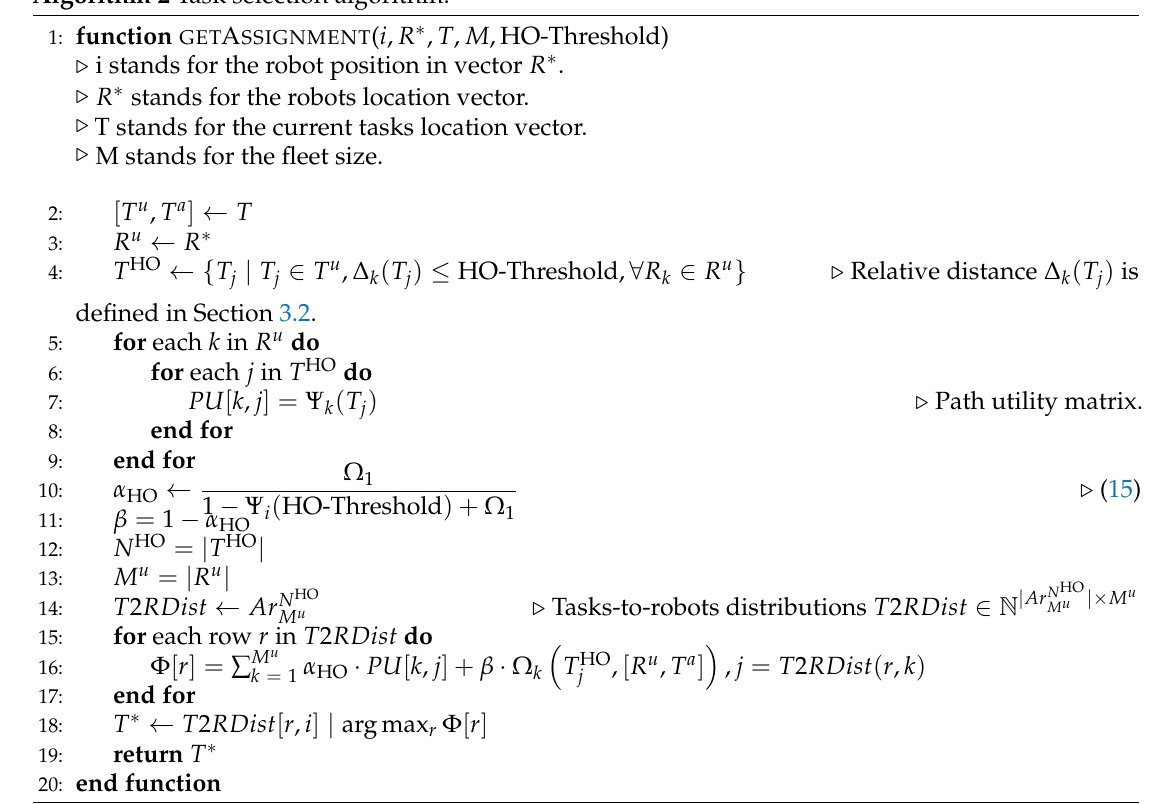
Algorithm 2 Task selection